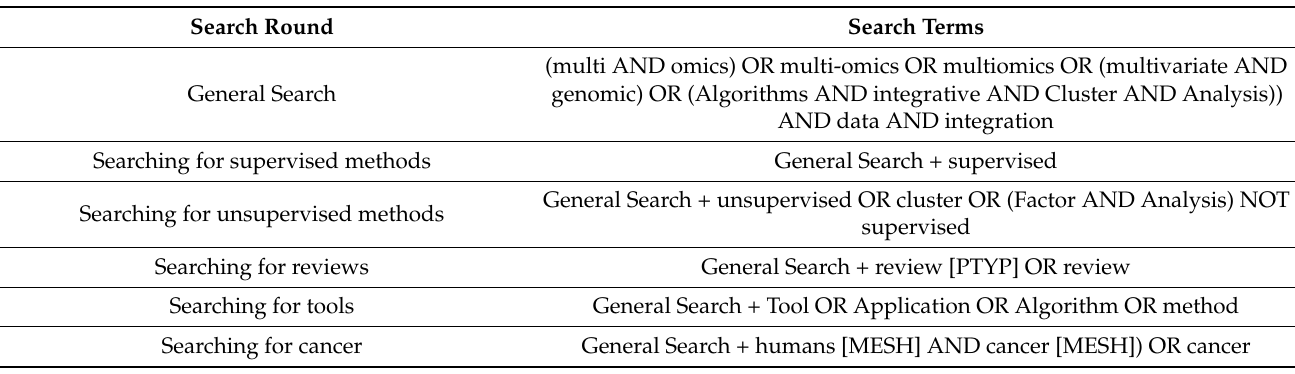
Table 8. Summary of search strategies and associated keywords for collecting multi-omics data integration associated publications with EDirect (PTYP: publication type; MESH: medical subject